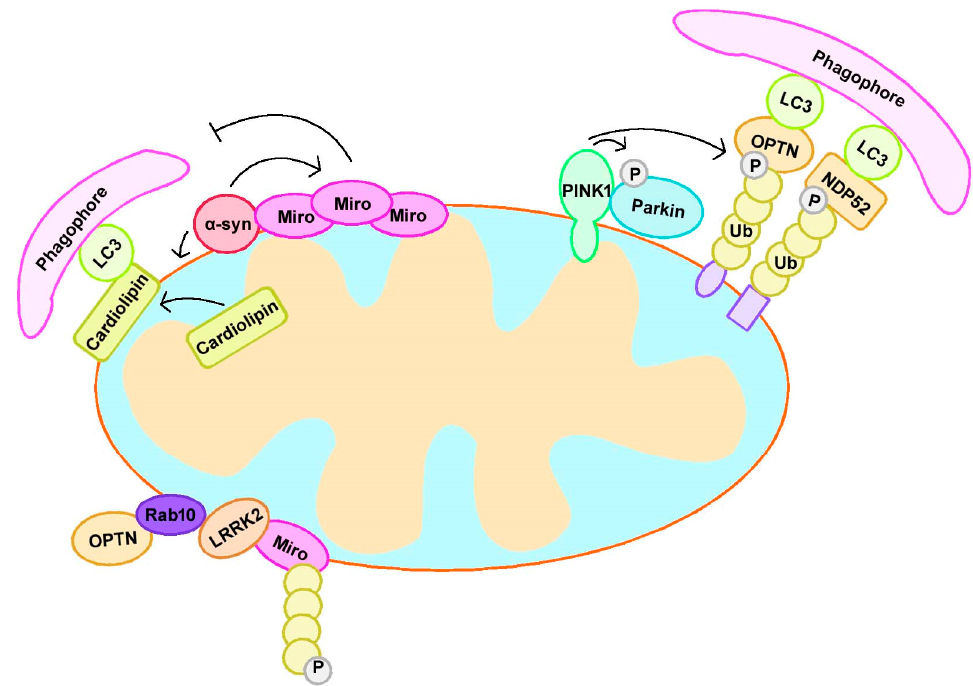
Figure 2. PD-related proteins participate in mitophagy. PINK1 accumulates at the outer mitochondrial membrane (OMM) and recruits Parkin to initiate mitophagy. α -syn interacts with Miro and upregulates Miro protein levels, leading to excessive, abnormal Miro accumulation on the mitochondrial surface and delayed mitophagy. Mitochondrial localized α -syn also promotes cardiolipin exposure on OMM; the latter further recruited LC3 to mitochondria and induced mitophagy. LRRK2 interacts with RAB10, which binds OPTN to induce mitophagy. LRRK2 interacted with Miro and contributed to its removal via mitophagy. NDP52, nuclear dot protein 52 kDa; OPTN, optineurin; Ub, ubiquitin.